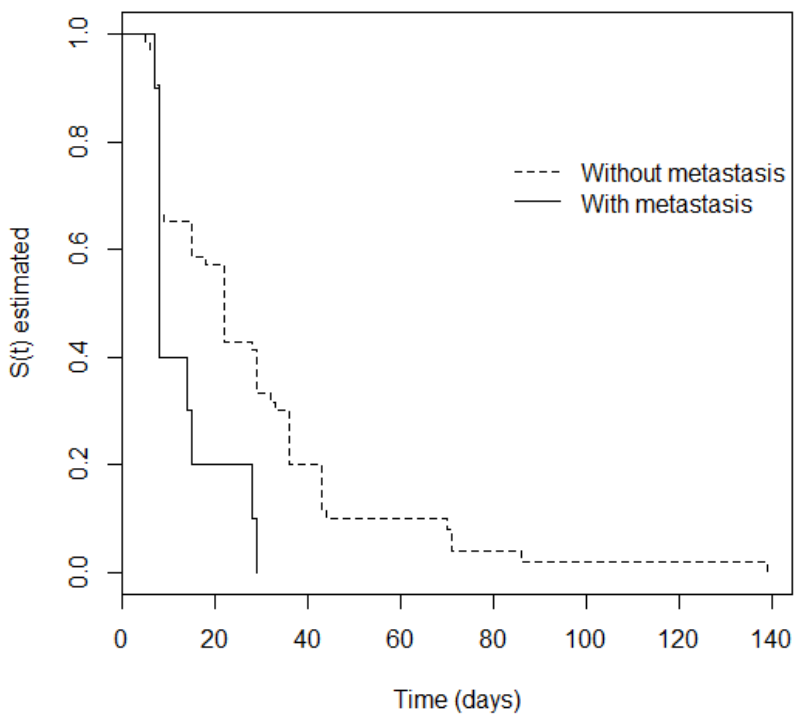
Figure 1. Kaplan-Meier analysis stratified for the metastasis variable of oncopediatric patients with severe oral mucositis in Napoleão Laureano Hospital. João Pessoa, Paraíba State, Brazil (2013–2017). Table 3. Log-normal regression model with all study variables and considering only significant variables of oncopediatric patients with severe oral mucositis in Napoleão Laureano Hospital. João Pessoa, Paraíba State, Brazil (2013–2017).